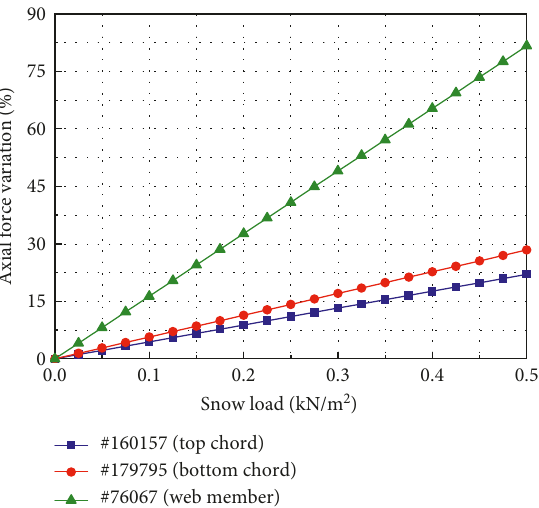
Figure 27: Axial force variations under nonuniformly distributed snow